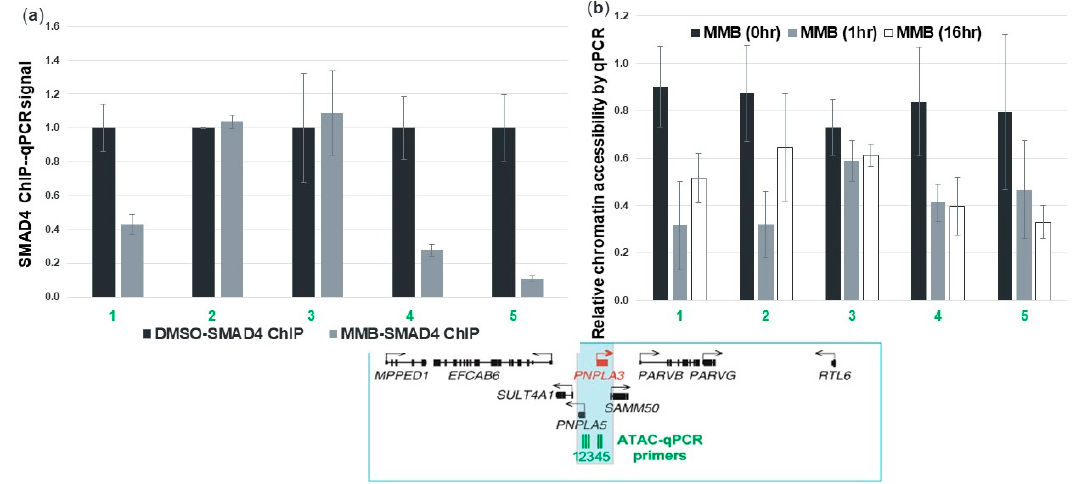
Figure 7. Momelotinib reduces PNPLA3 at the level of transcription. The qPCR primers were designed to amplify peak regions of H3K27Ac and H3K4me1, two epigenetic hallmarks of active enhancer elements identified within the PNPLA3 locus based on ENCODE datasets (shown in green). Chromatin immunoprecipitation (ChIP) for SMAD4 protein binding to predicted PNPLA3 enhancer regions shows a dramatic loss of binding at most of these sites upon momelotinib treatment. ( a ) Assay of chromatin accessibility (ATAC) at these same enhancer regions shows reduced chromatin accessibility after 1 h and 16 h of momelotinib treatment, compared to DMSO. ( b ) Reduced accessibility at these regions is consistent with the loss of transcription factor(s) that promote PNPLA3 transcription upon momelotinib treatment. All bars represent averages of at least three independent